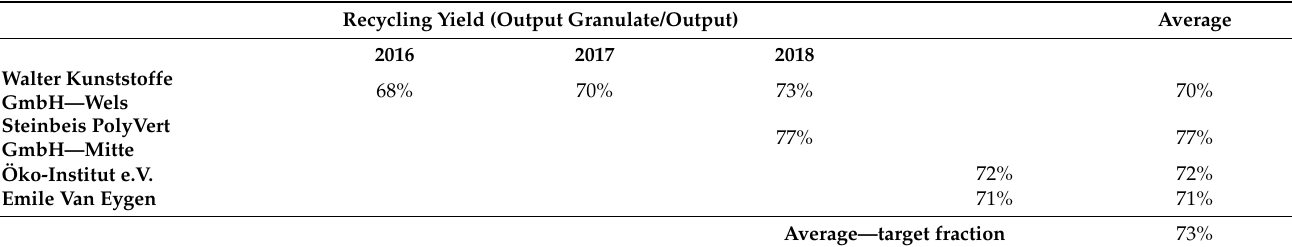
Table A6. Data collection and calculation of the recycling yield